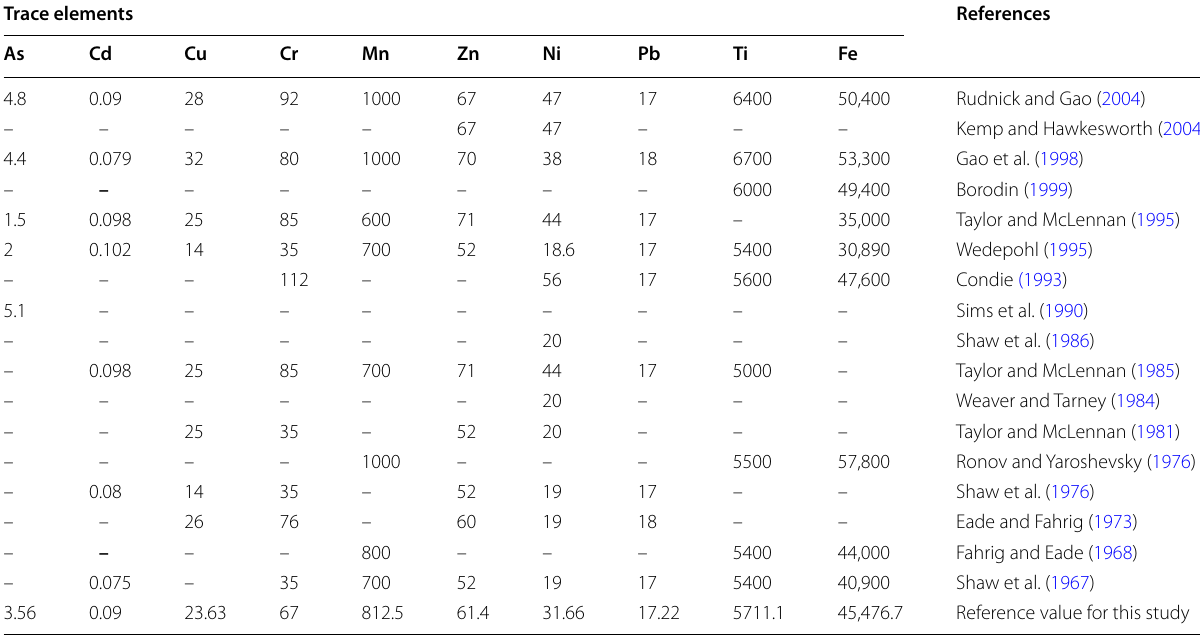
Table 7 Upper continental crust values of trace elements from previous studies Trace elements